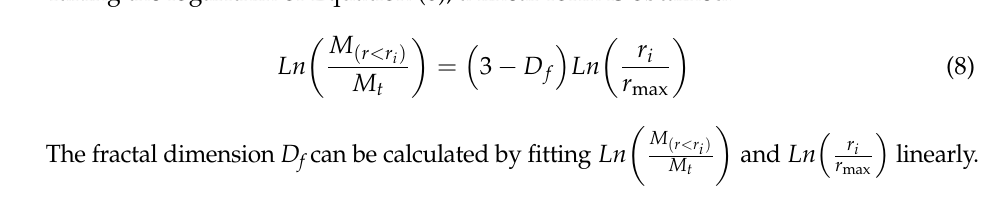
Figure 6. Dynamic stress–strain curves for different PSDs: ( a ) S 3 series; ( b ) S 4 series; ( c ) S 5 series.